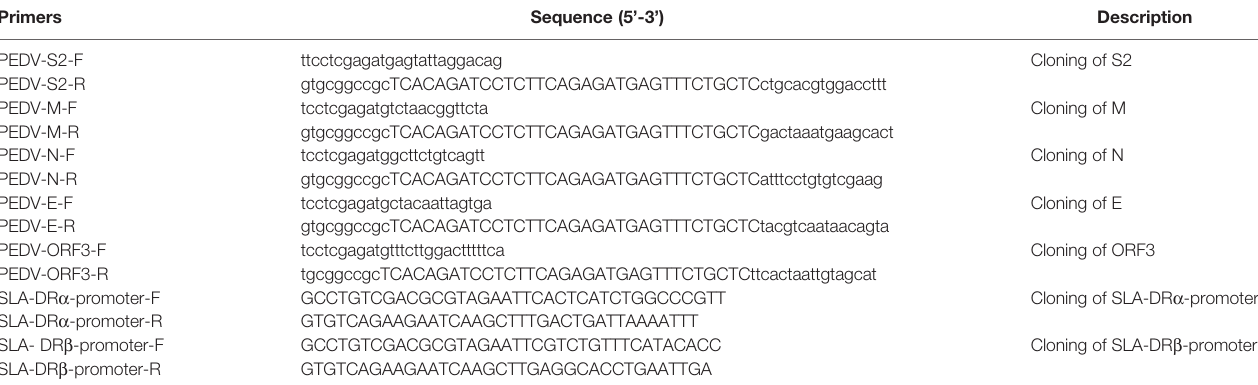
TABLE 1 | List of primers using for plasmids